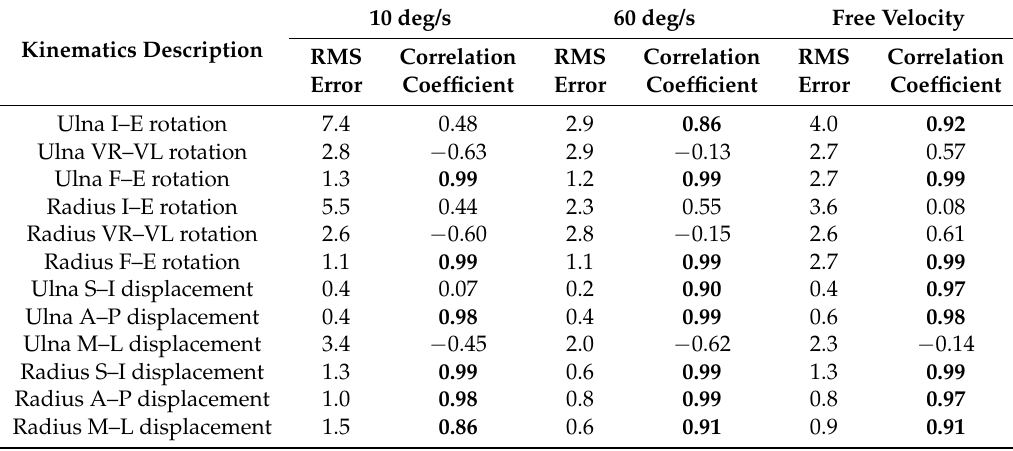
Table 2. RMS error (deg, mm) and correlation coefficients for ulna and radius kinematics (good correlations are in